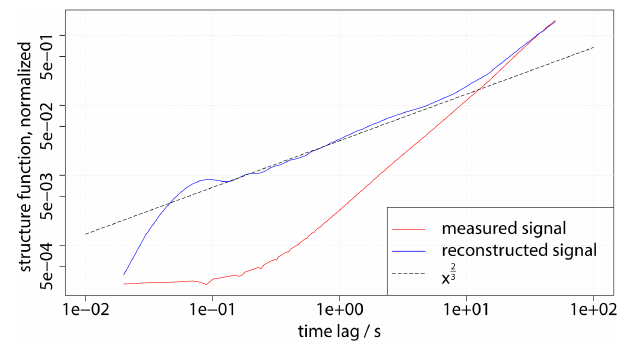
Figure 10. Structure function before and after correction.The num- ber of layers in the sensor model is set to N = 40. The diffusion constant was found to be D = 0.1µm 2 s − 1 from the vertical profile. The structure function is normalized by 2 σ 2 and averaged over five flight